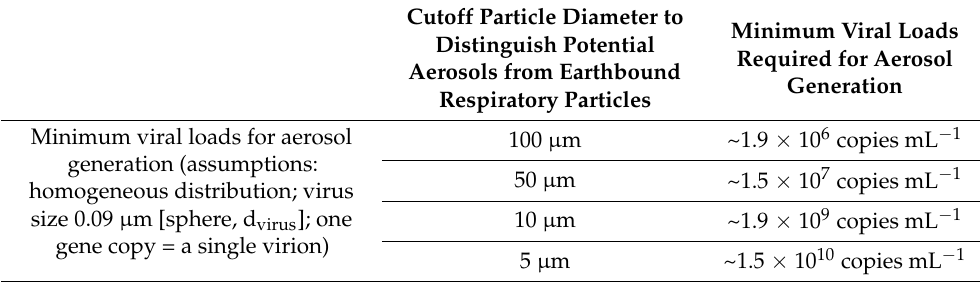
Cutoff Particle Diameter to Minimum Viral Loads Distinguish Potential Required for Aerosol Aerosols from Earthbound Generation Respiratory Particles